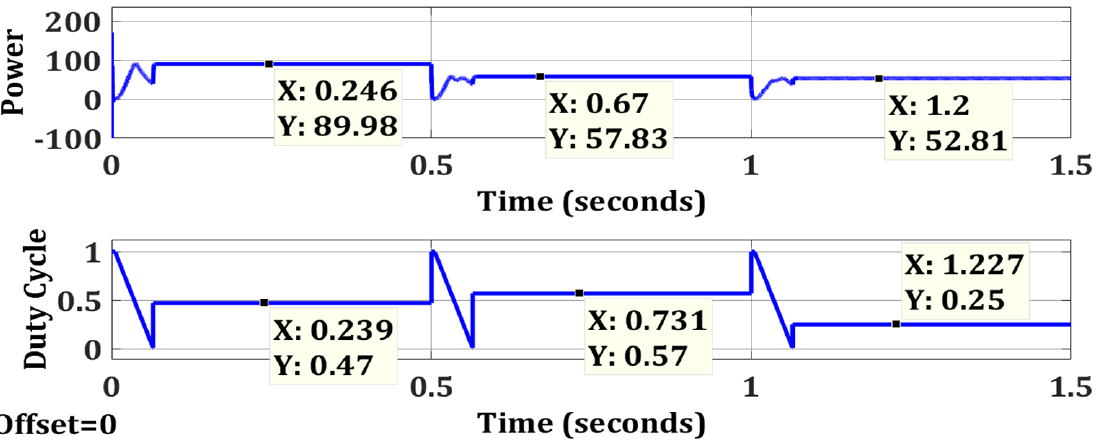
Figure 23. Changing weather condition for 3S PV system .